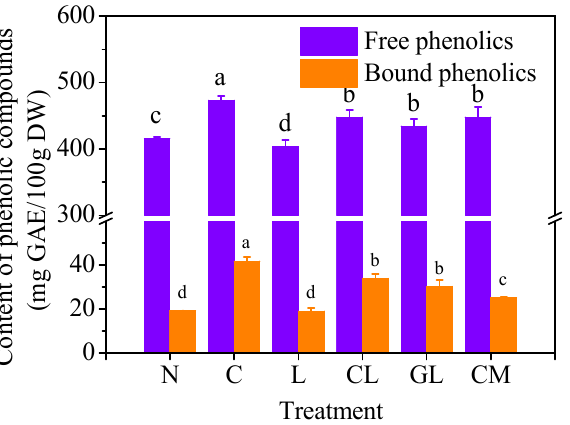
Figure 1. Content of phenolic compounds (mg GAE/100 g DW) in soybean sprouts (n = 3). Treatments were as follows: N: NaCl; C: NaCl + CaCl 2 ; L: NaCl + LaCl 3 ; CL: NaCl + CaCl 2 + LaCl 3 ; GL: NaCl + GABA + LaCl 3 ; CM: NaCl + CaCl 2 + 3-mercaptopropionate (3-MP). Values bearing different letters in each form are significantly different ( p <